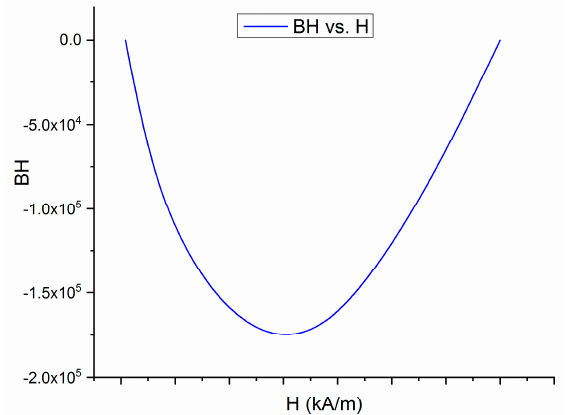
Figure 10. BH vs H plot as obtained from the demagnetization curve.